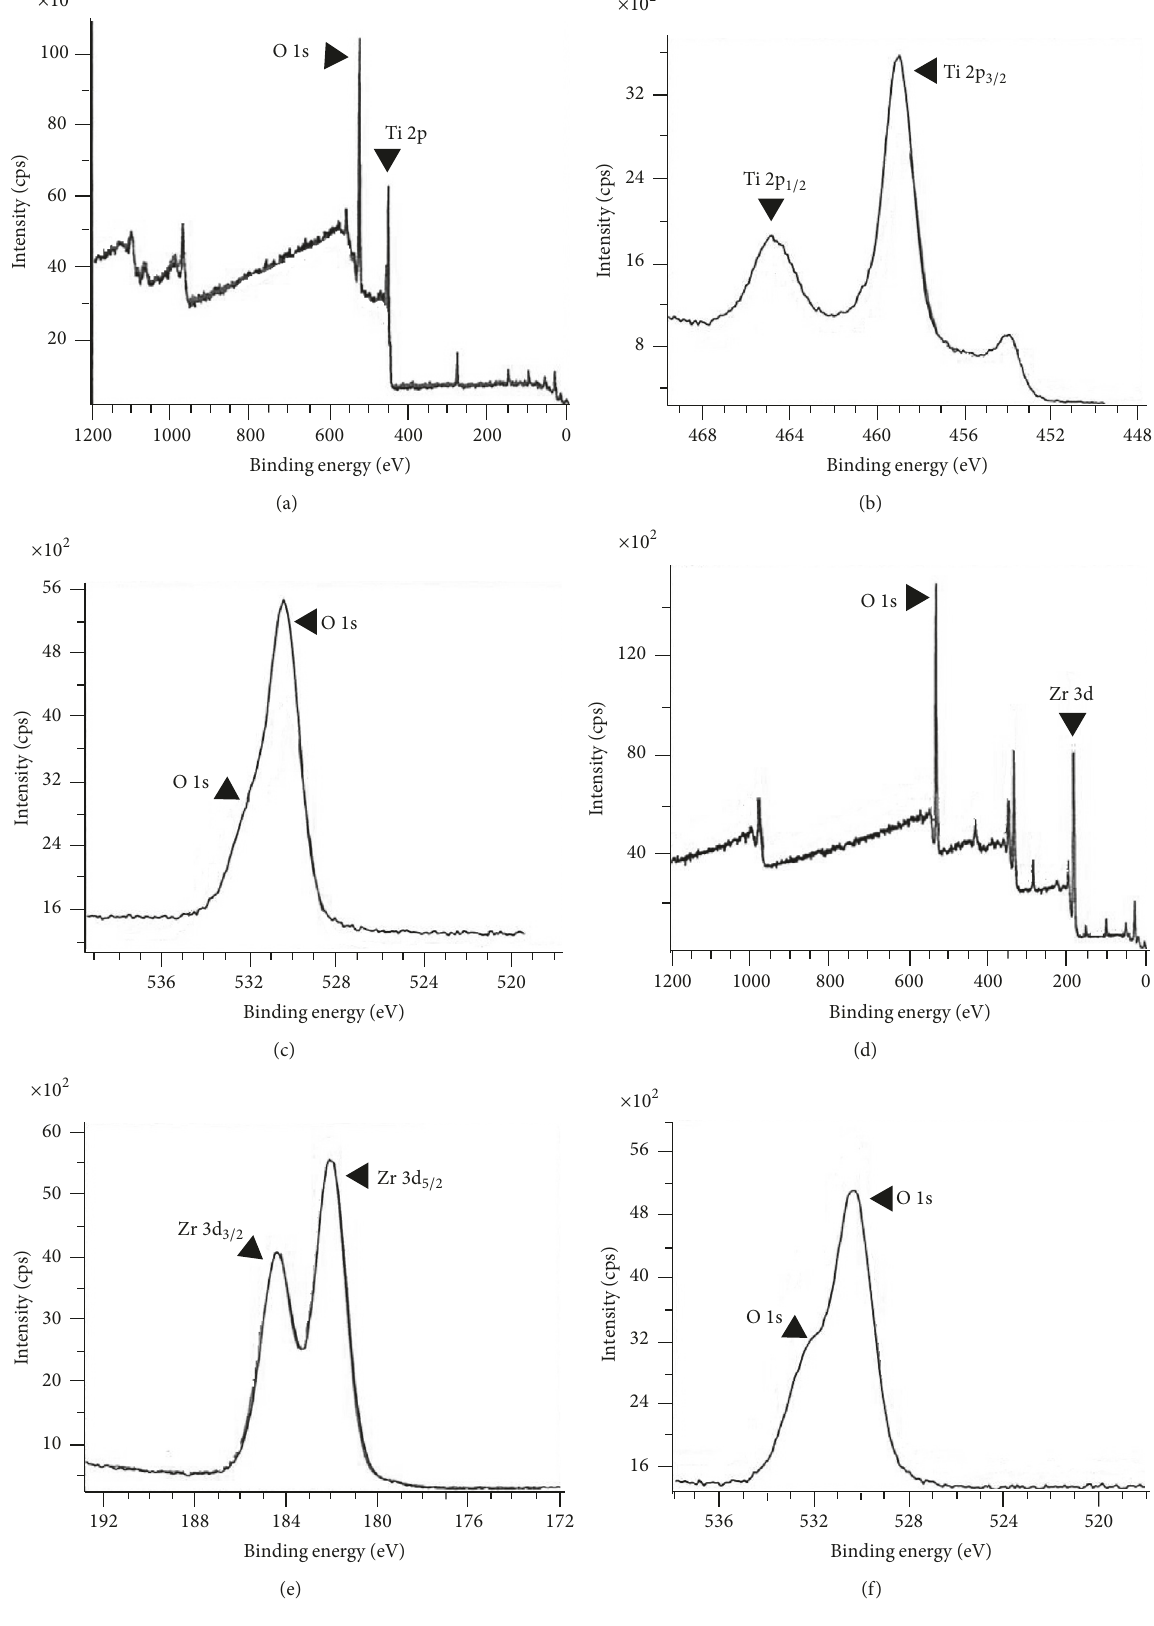
Figure 1: XPS analysis of Ti and ZrO 2 sensors. (a) XPS spectrum of the Ti sensor, (b) higher resolution XPS spectrum of Ti2p of the Ti sensor, (c) higher resolution XPS spectrum of O1s of the Ti sensor, (d) XPS spectrum of the ZrO 2 sensor, (e) higher resolution XPS spectrum of Zr3d of the ZrO 2 sensor, and (f) higher resolution XPS spectrum of O1s of the ZrO 2